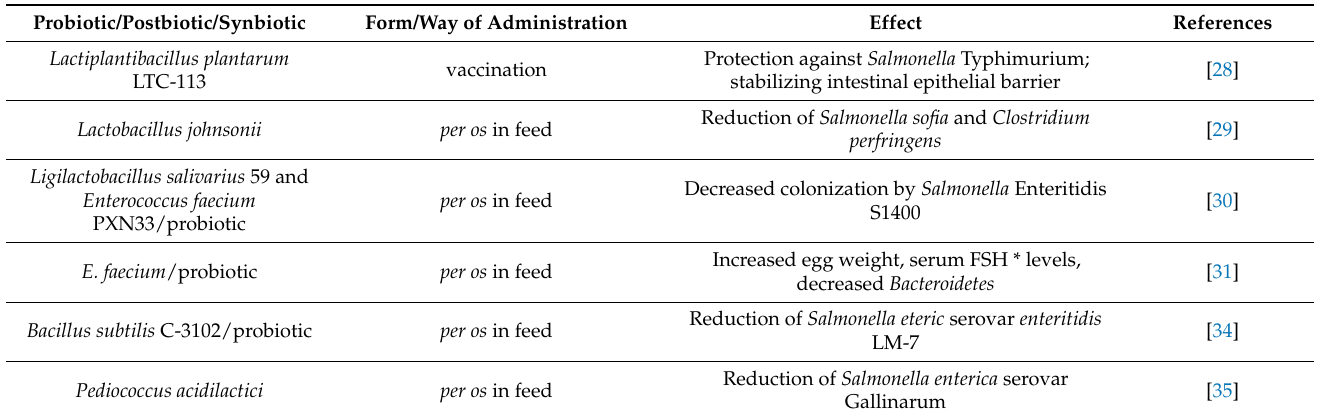
Table 1. Overview of the application of beneficial bacteria in poultry farming in an in vivo study.